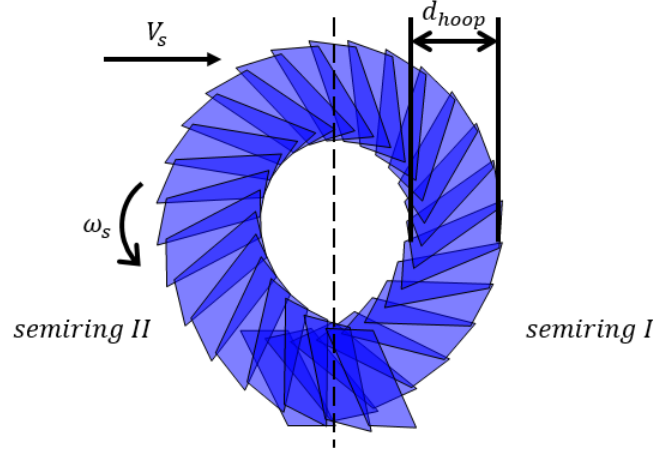
Figure 9. Region division of a ring.